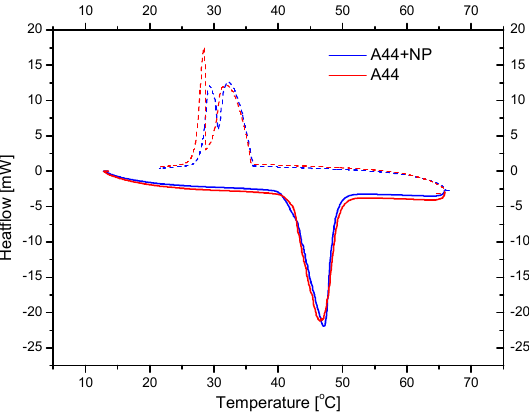
Figure 6. DSC results of A44 and A44 + NP on heating and cooling cycle under 2.0 °C/min.